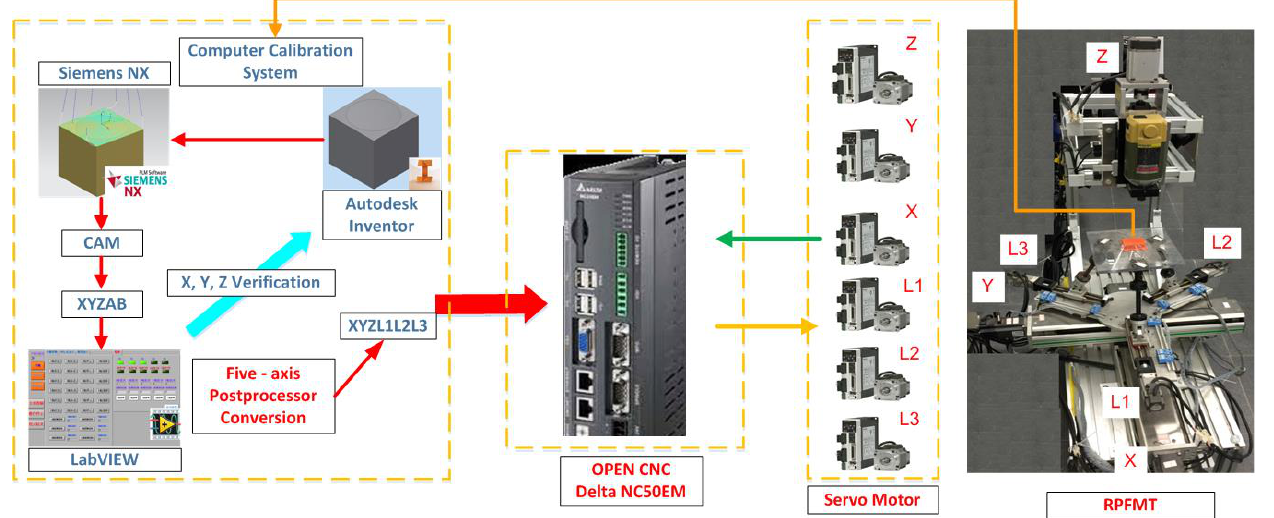
Figure 8. Architecture of the RPFMT.